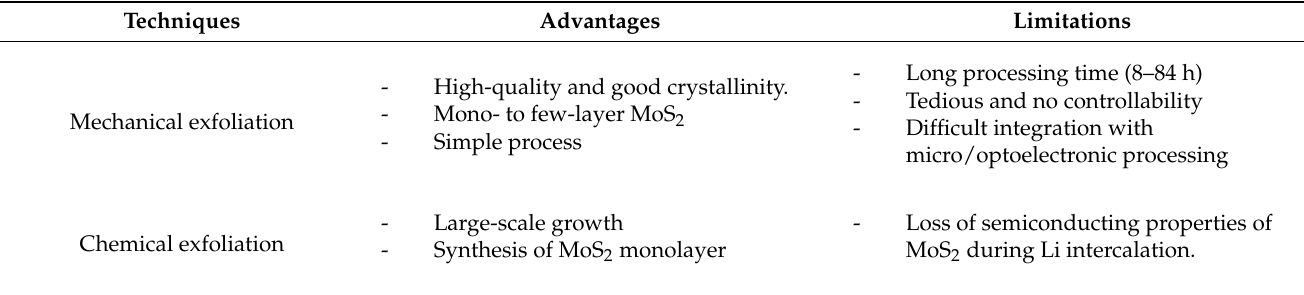
Table 6. Comparison of the advantages and limitations of different preparation techniques of MoS 2 .